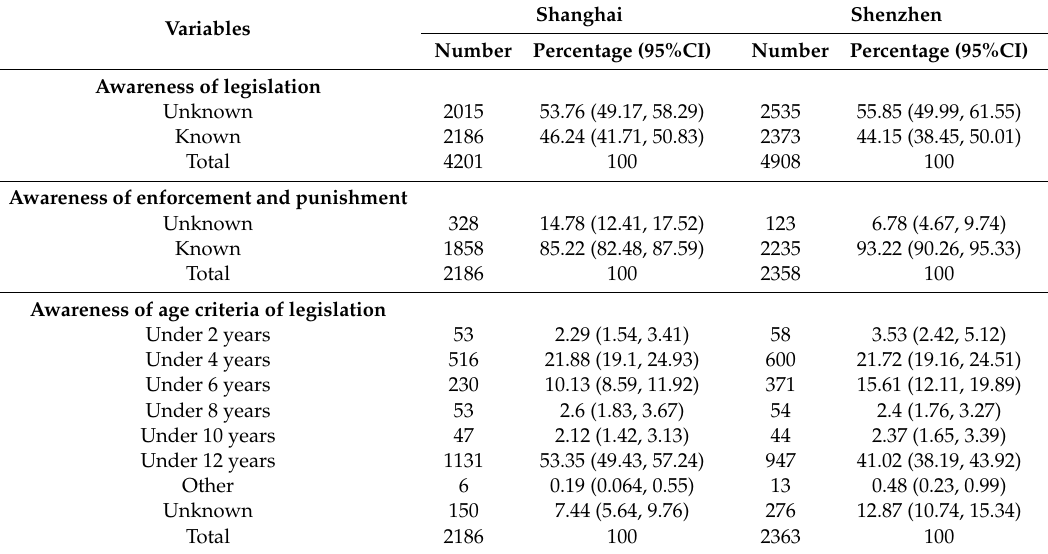
Table 2. Awareness of local legislation in the two